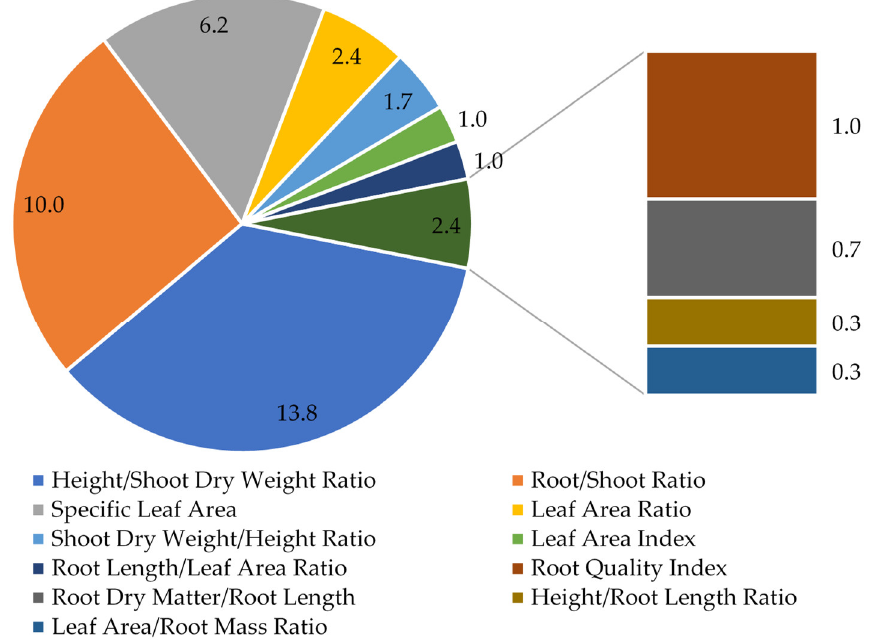
Figure 8. Main plant quality indicators observed in the analysed publications. Data are expressed as percentage ( n = 289).